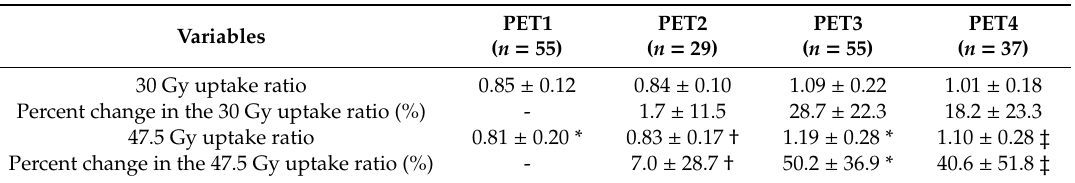
Table 3. 30 Gy uptake ratios, 47.5 Gy uptake ratios, and the percent changes in the 30 Gy and 47.5 Gy uptake ratios in patients with left breast cancer. Variables